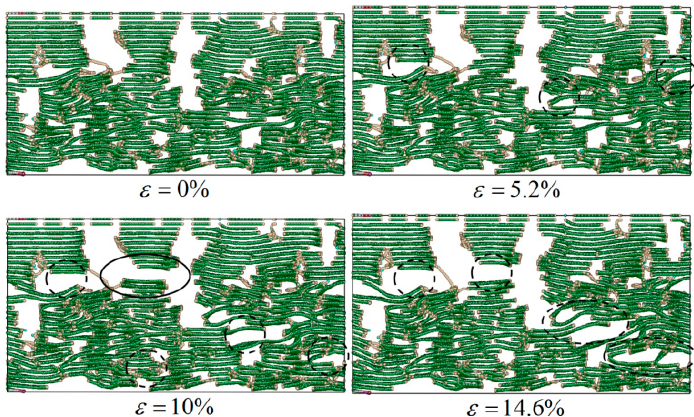
Materials 2019 , 12 , x FOR PEER REVIEW Figure 7. Typical failure modes of the C f /PyC interphase under a normal tensile load when L a = 3 nm.